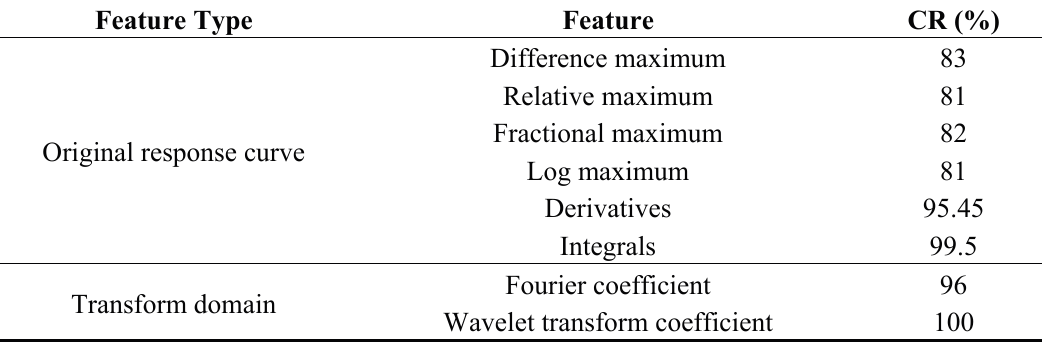
Table 11. Classification rates (CR) of different features in